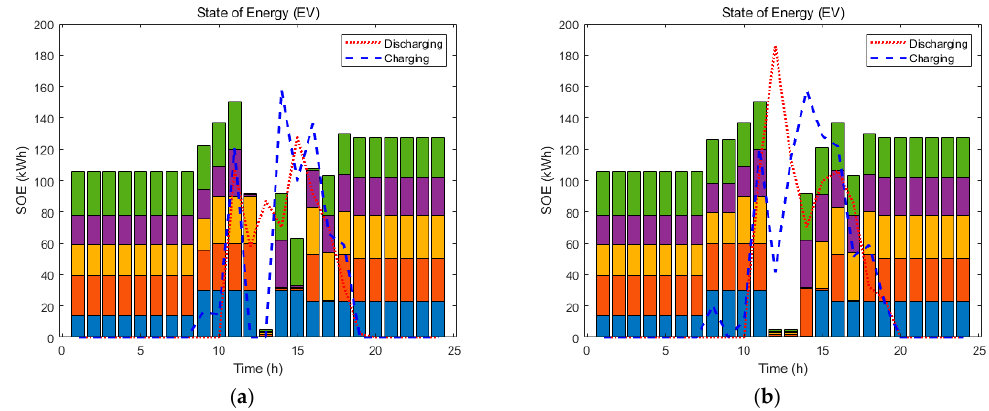
Figure 11. Optimal SOE of EVs scheduling results in winter: ( a ) Without DR; ( b ) with DR.